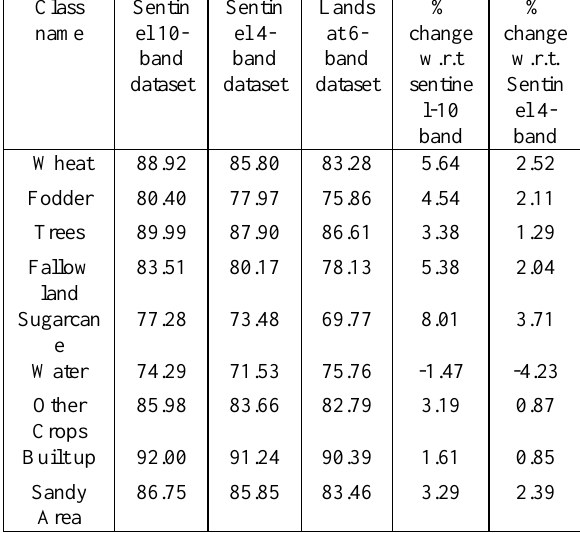
Table 3. F1-measure for Landsat-8 OLI, Sentinel 4 band and Sentinel 10 band using MLC algorithm and change